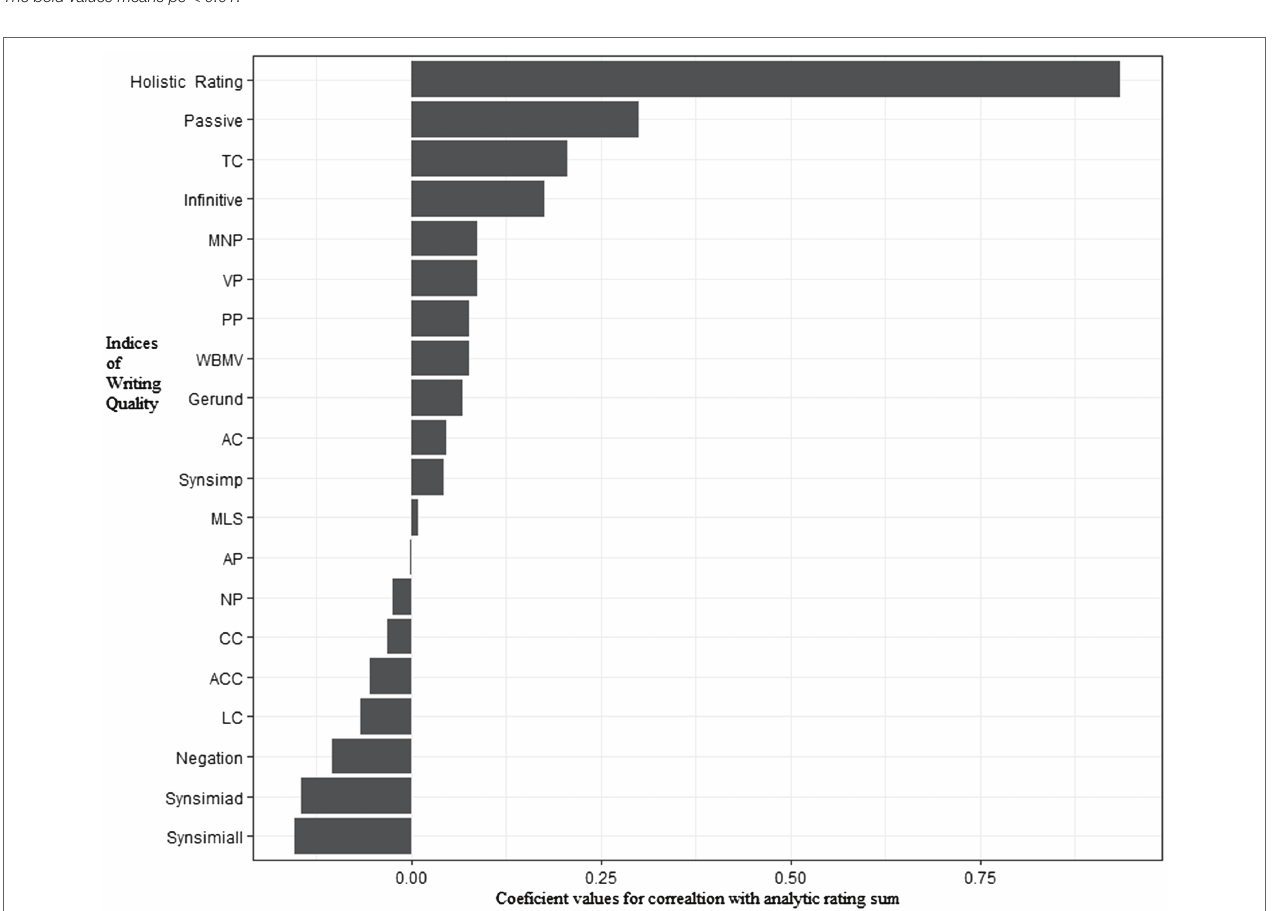
FIGURE 1 | Patterns of correlations between syntactic complexity indices and analytic